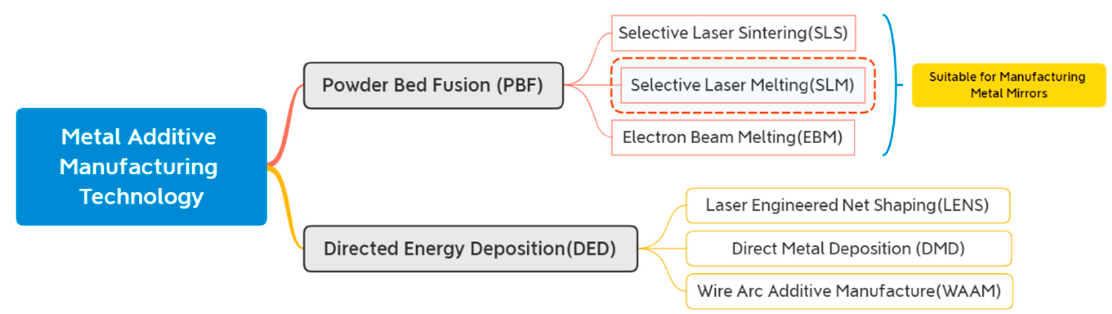
Figure 6. Classification of metal AM technology.